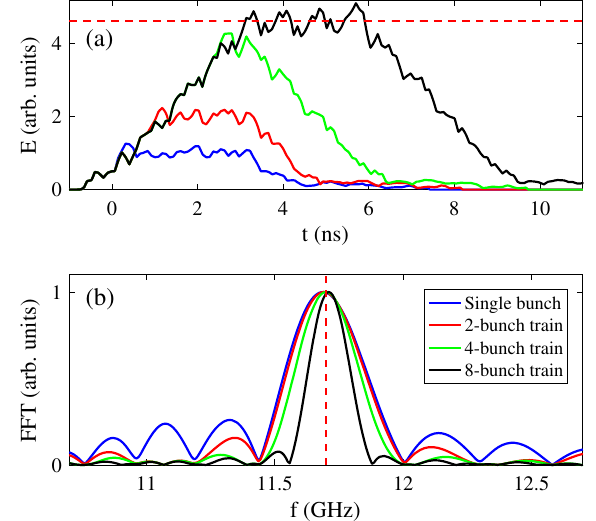
FIG. 7. Envelop (a) and spectrum (b) of the coupler output rf signal. For bunch trains, the field is calculated by summing those driven by a single bunch with proper delays. The field amplitude is normalized to that driven by a single bunch. The horizontal and vertical red dashed lines indicate the average amplitude of the flat-top driven by the 8-bunch train and f ¼ 11 . 7 GHz,